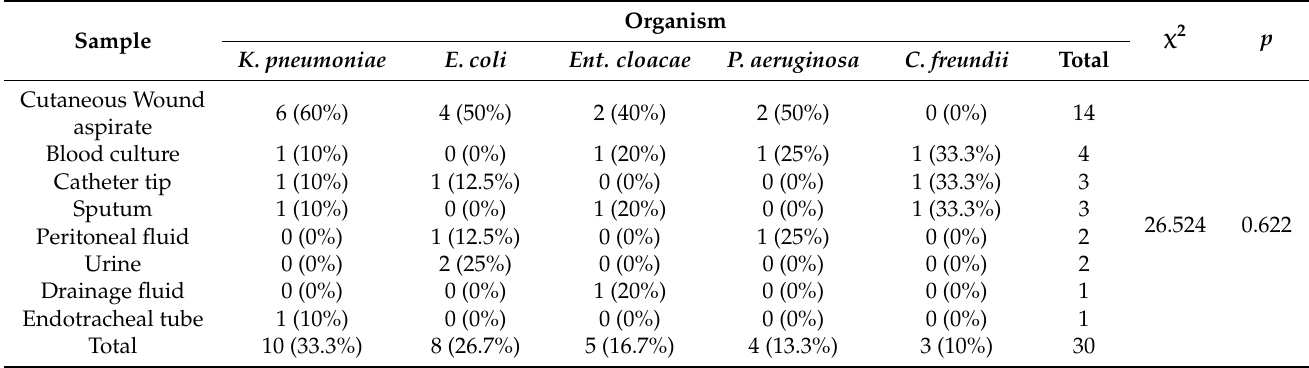
Table 3. Frequency of organisms isolated from different samples.